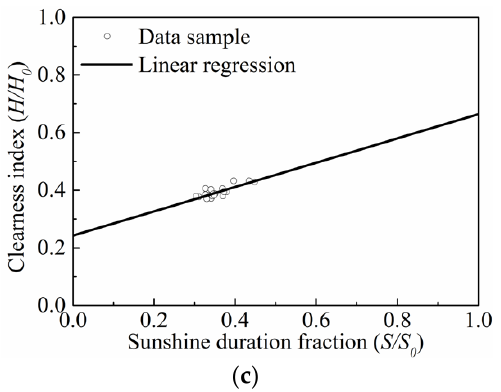
Figure 4. Linear regression using different time scales: ( a ) daily time scale; ( b ) monthly time scale; and ( c ) yearly time scale.